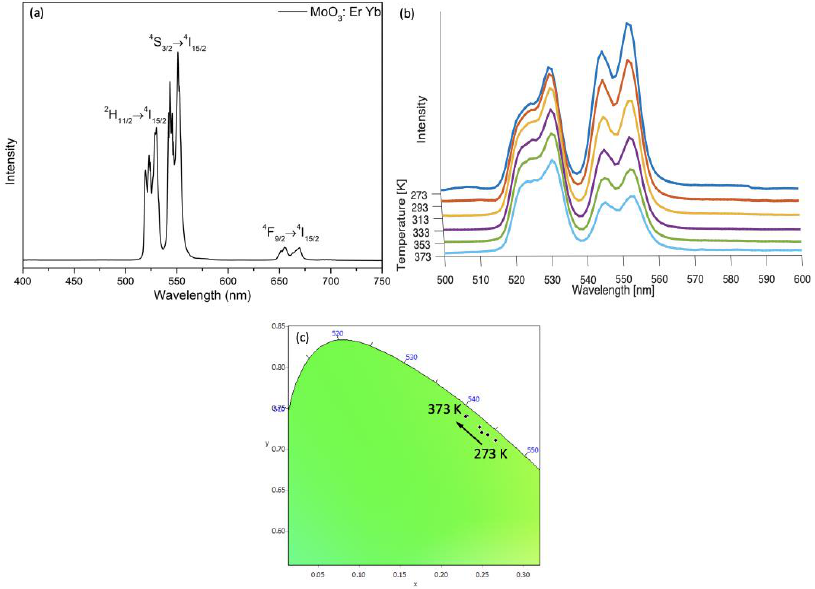
Figure 8. ( a ) Emission spectrum of α -MoO 3 :Er 3 + , Yb 3 + under excitation at 975 nm measured at room temperature; ( b ) the temperature evolution of the emission spectra of α -MoO 3 :Er 3 + , Yb 3 + recorded in the range of 273–373 K (step of 20 K); ( c ) CIE diagram presenting the observed color change with temperature